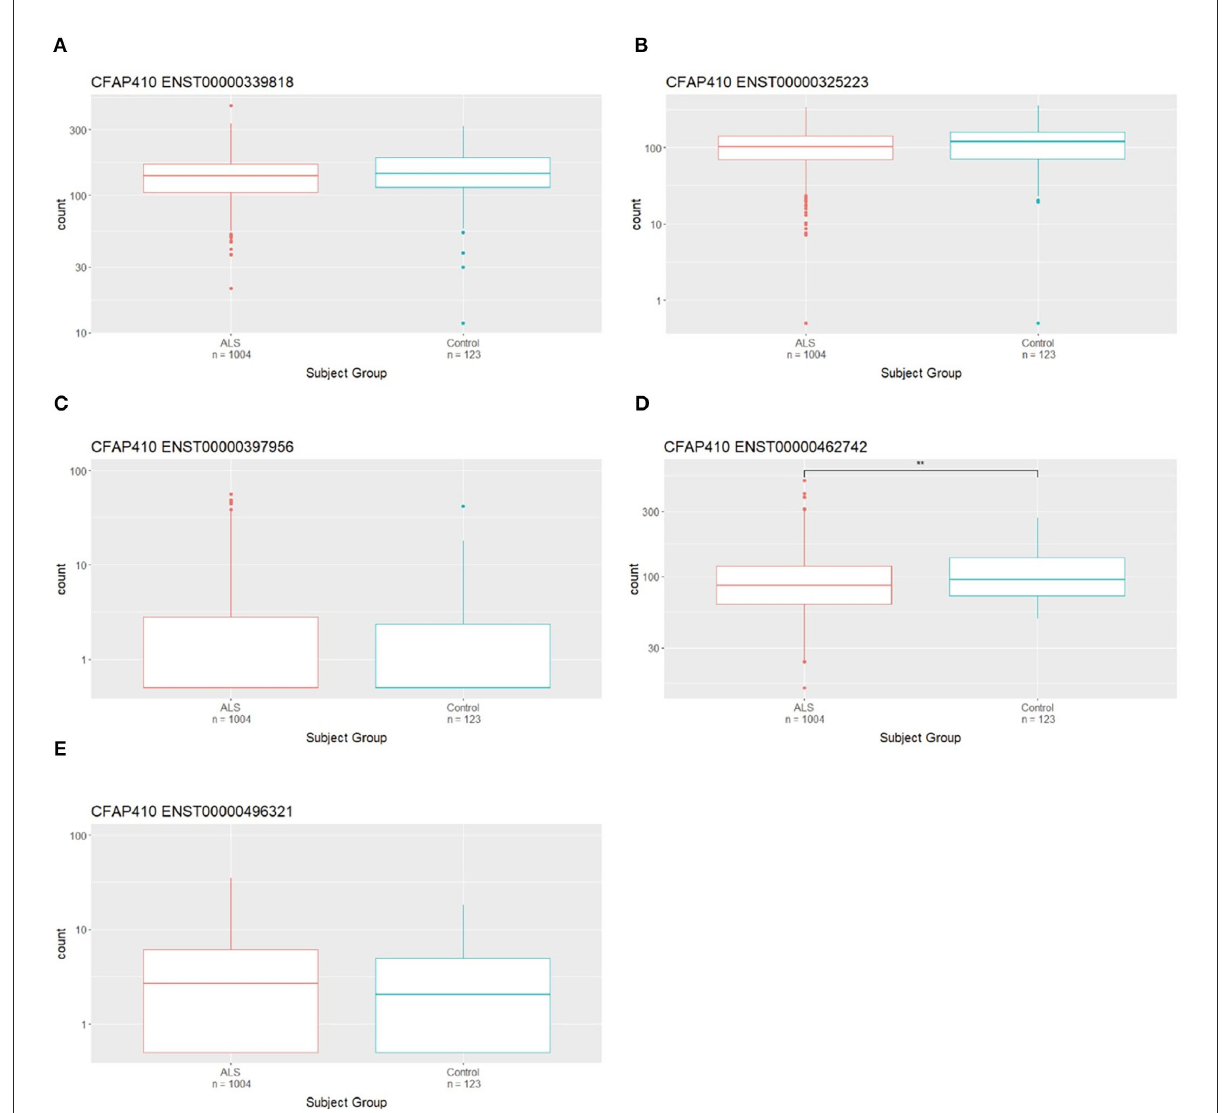
FIGURE2 Differential expression of CFAP410 in Case and Controls in the CNS using the NYG transcriptomic data. Expression analysis of CFAP410 isoforms in ALS and control subjects. RNAseq data from the NYGC ALS cohort were used to compare expression of CFAP410 isoforms ENST00000339818 (A) , ENST00000325223 (B) , ENST00000397956 (C) , ENST00000462742 (D) and ENST00000496321 (E) . Wilcoxon test was applied to demonstrate statistical significance indicated as asterisks. ** P ≤